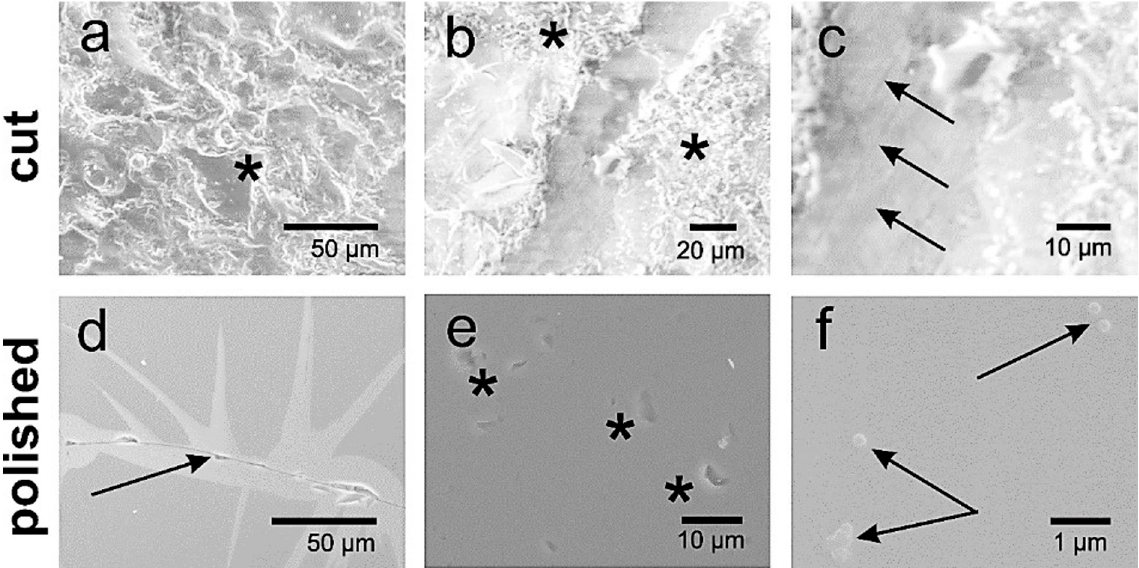
Figure A2. The SEM micrographs of the fresh cut GAp ( a – c ) and finely polished YAp ( d – f ) surfaces. ( a ) Diamond-saw cut surface of GAp (001) plate with smooth cleaved fragment marked by an asterisk. ( b ) GAp (100) plate with fractured areas (marked by asterisks) and smooth fragment in between. ( c ) The higher magnification (1000×) of ( b ) stepped cleavage of smooth fragment–arrows marks the edges of steps. ( d ) Inclusion or strain area in YAp (101) plate surrounding a fracture pointed with the arrow. ( e ) The fragment of (101) YAp plate with post-inclusion cavities (marked with the asterisks). ( f ) The higher magnification (×10,000) of finely polished YAp surface with the bubble-like inclusions or debris indicated by the arrows.